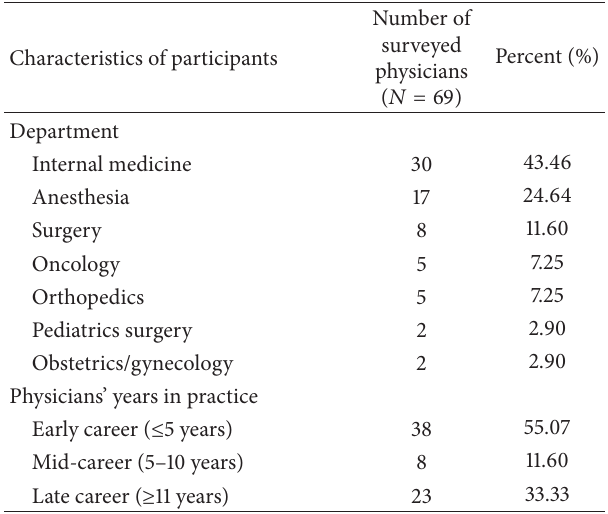
Table 1: Characteristics of